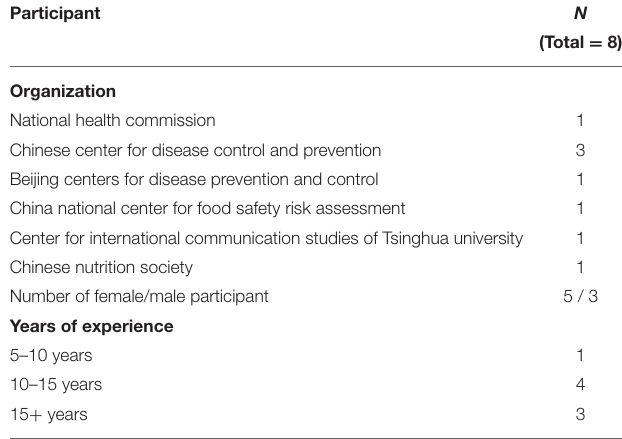
TABLE 1 | Characteristics of